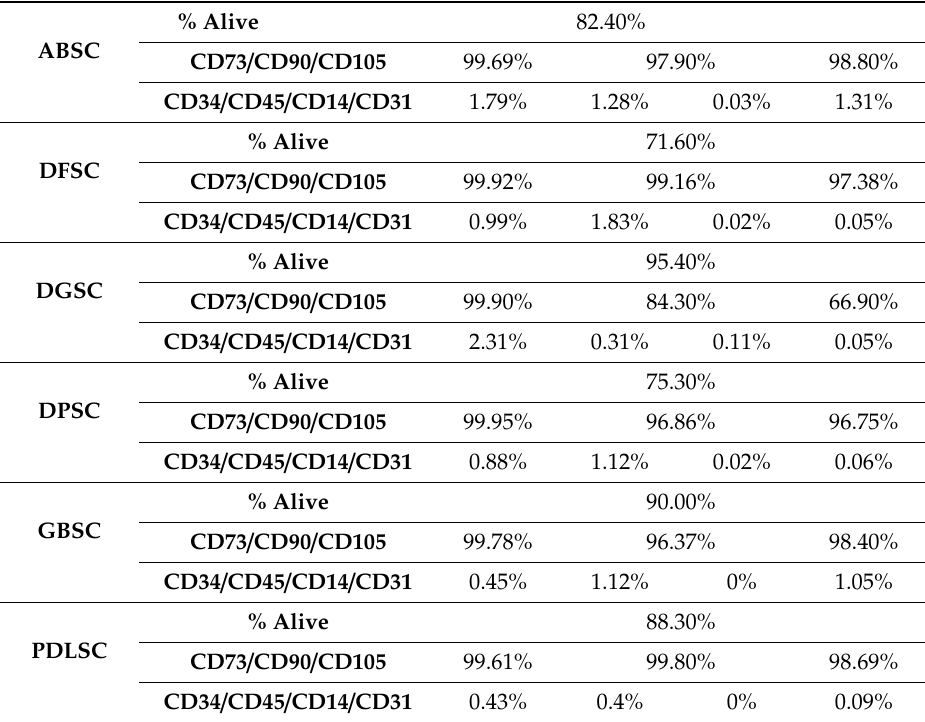
Figure 2. Clonogenicity potential of each cell population. No statistically significant differences were detected. Data are shown as mean (SD). Table 2. Expression of mesenchymal stromal cell (MSC) surface markers.